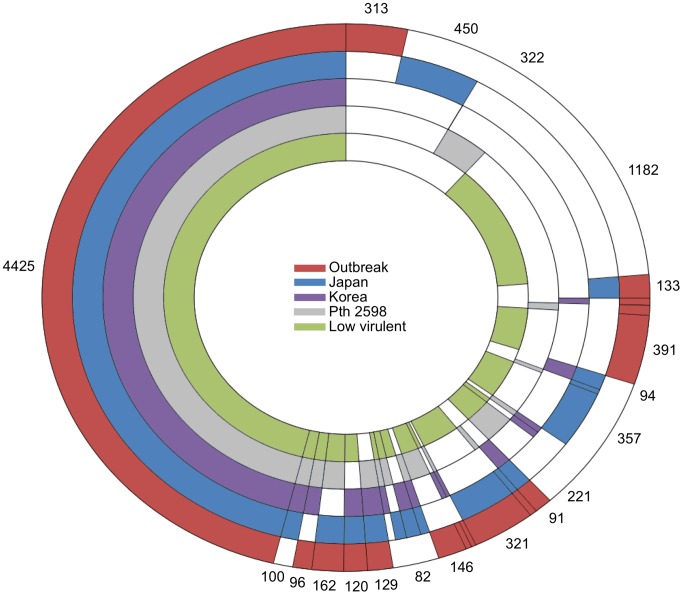
Unique and shared ortholog groups between clades.Numbers outside the rainbow plot show the number of ortholog groups with at least one representative ORFs per strain per clade.